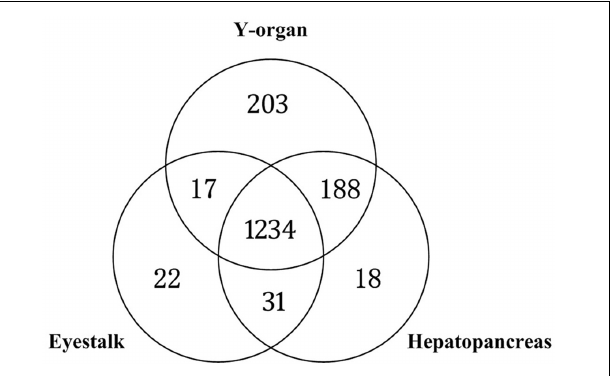
FIGURE 7 | Comparison of Y-organ, eyestalk, and hepatopancreas genome-scale metabolic networks (GSMNs).